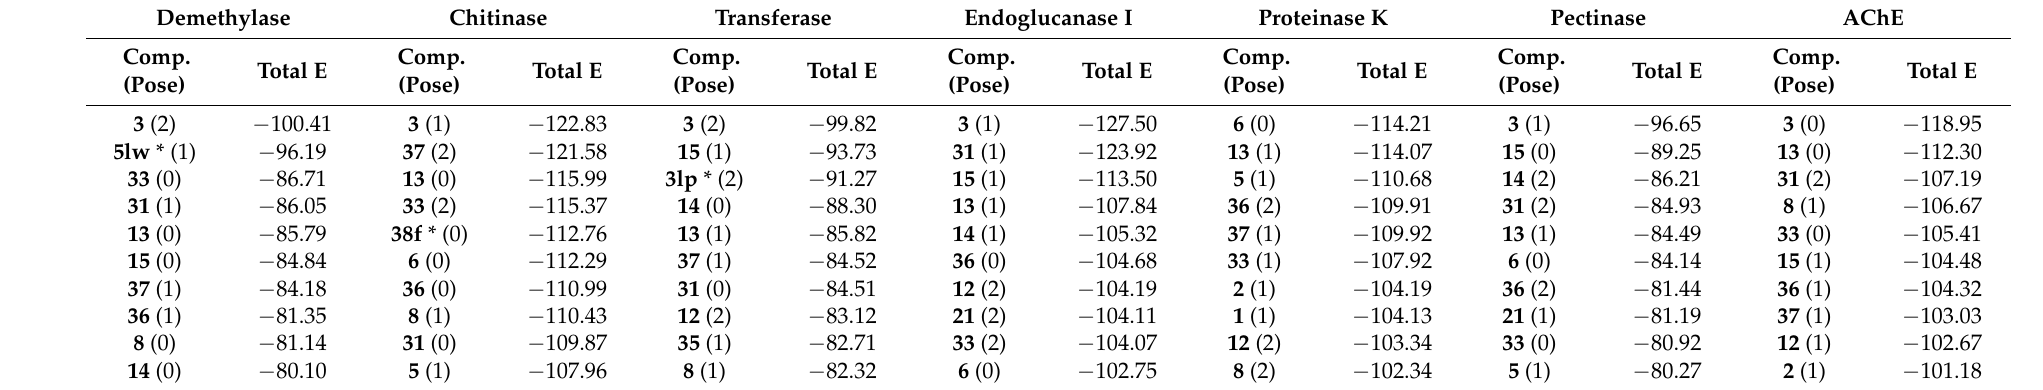
Table 8. Docking score energies (Total E/kcal mol − 1 ) of interactions of the best ten docked poses of coumarin derivatives, including standard ligands * in complex with: demethylase (sterol 14 α -demethylase (CYP51), pdb ID: 5eah); chitinase (pdb ID: 4txe); transferase (N-myristoyltransferase, pdb ID: 2p6g); endoglucanase I (pdb ID: 2ovw); proteinase K (pdb ID: